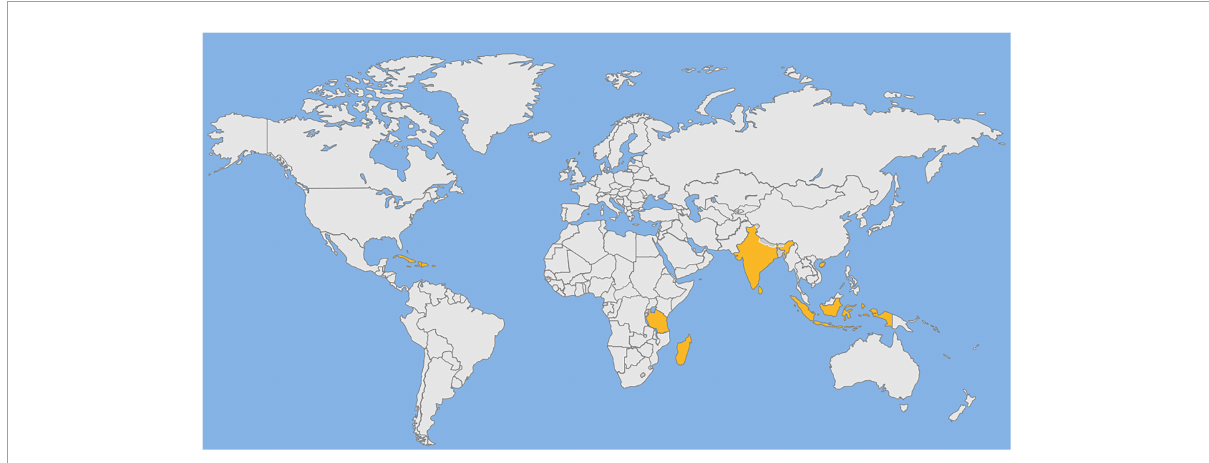
FIGURE1 Distribution of S. aromaticum around the world. West Indies, Tanzania, Madagascar, India, Sri Lanka, Indonesia, Malaysia and Hainan province of